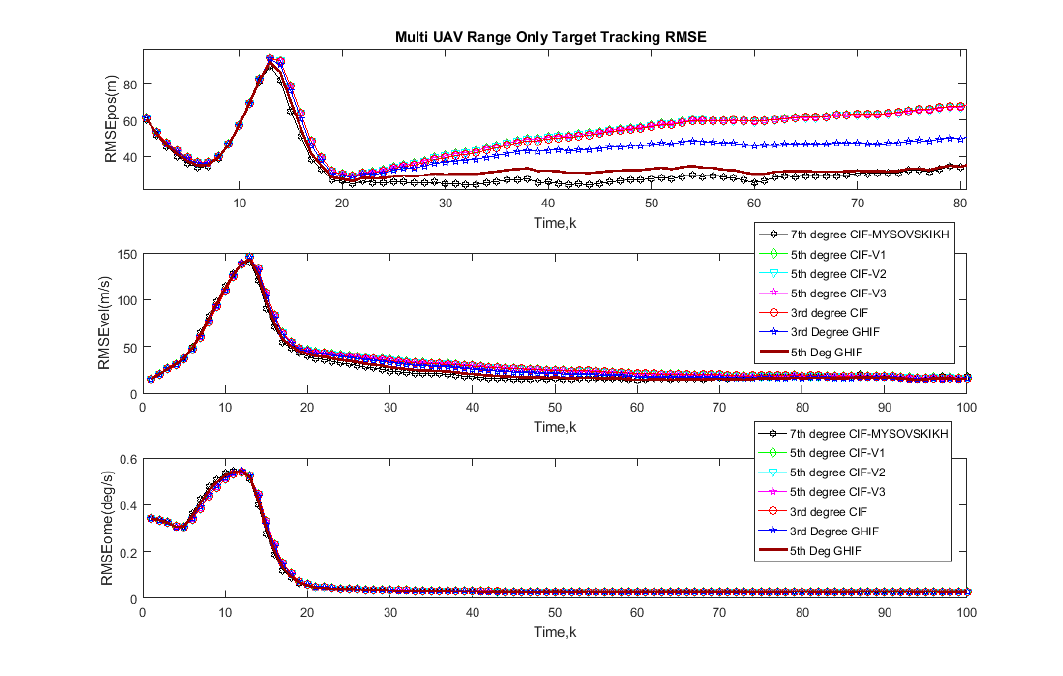
Figure 11. RMSE of range-only Doppler-based estimation: Results of 7 th -degree CIF, 5 th -degree CIF, 5 th -degree GHIF, 3 rd -degree